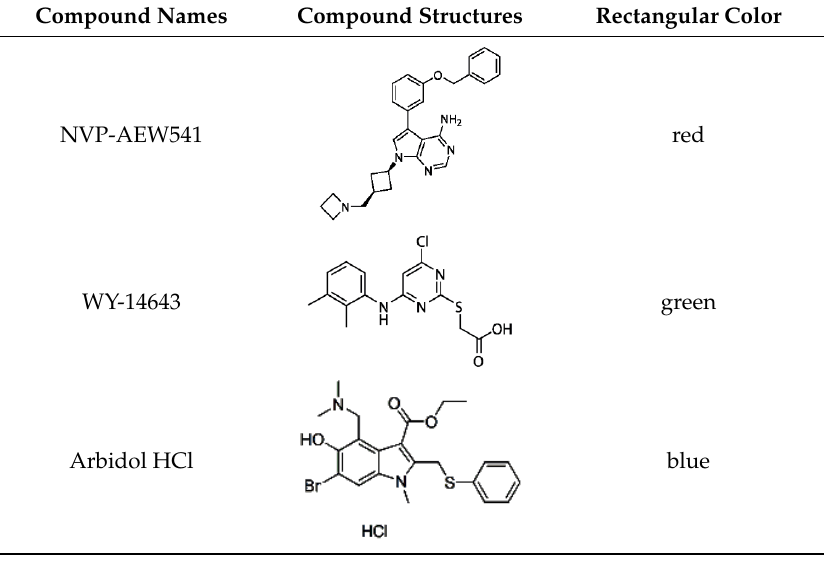
Figure 8. Combined auto-fluorescence/OI-RD image of a printed-and-washed compound microarray ( a ) on a hexyl-isocyanate functionalized slide and ( b ) on a phenyl-isocyanate functionalized slide. Table 1. Structures of three light spots in Figure 8b highlighted by color rectangles.